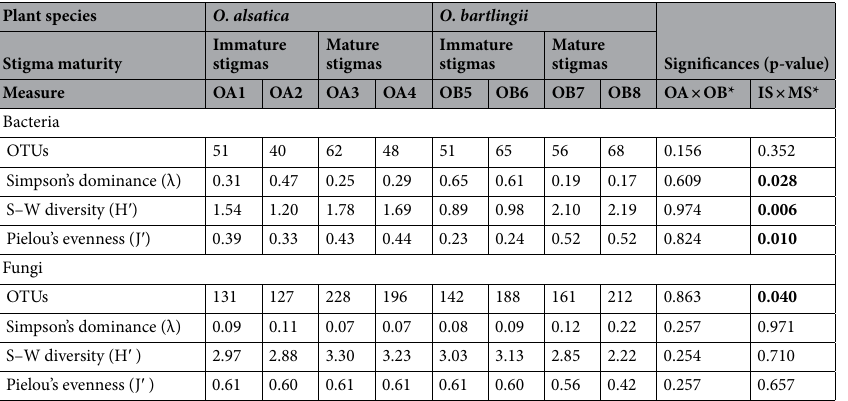
Table 1. OTUs and diversity indices of microbiota identified in Orobanche alsatica (OA) and O. bartlingii (OB) in immature stigmas from closed flowers (1, 2, 5, 6) (IS) and mature stigmas from opened flowers (3, 4, 7, 8) (MS) and statistical calculation. *Only OTUs with significant biological differences ( P < 0.05) were marked. Significant values are in